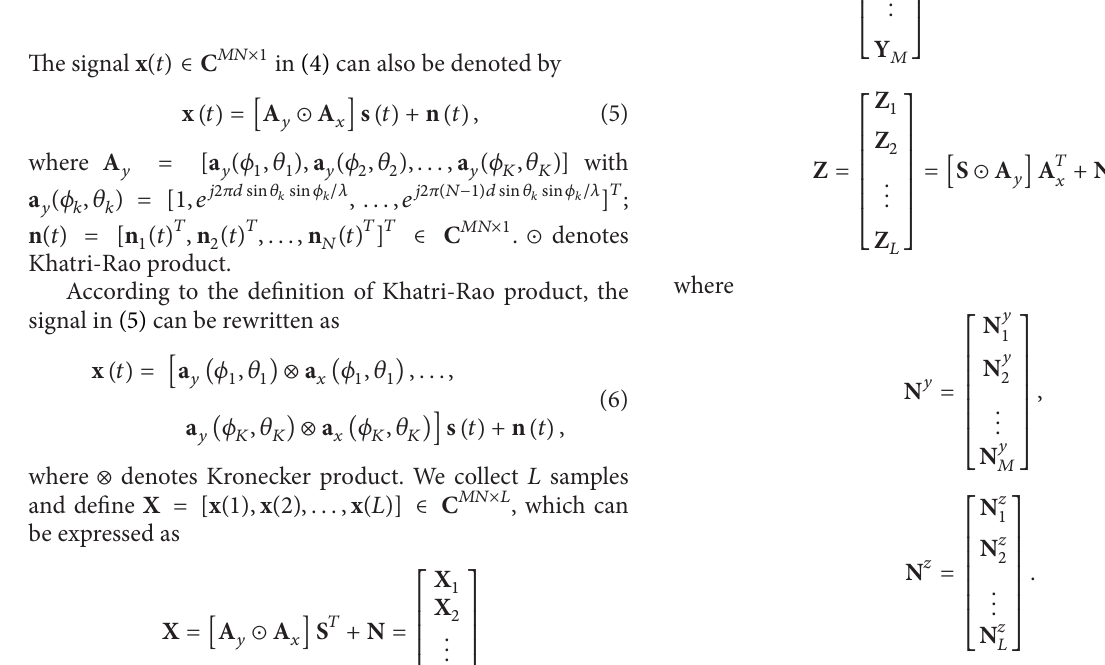
Figure 1: The structure of uniform rectangular